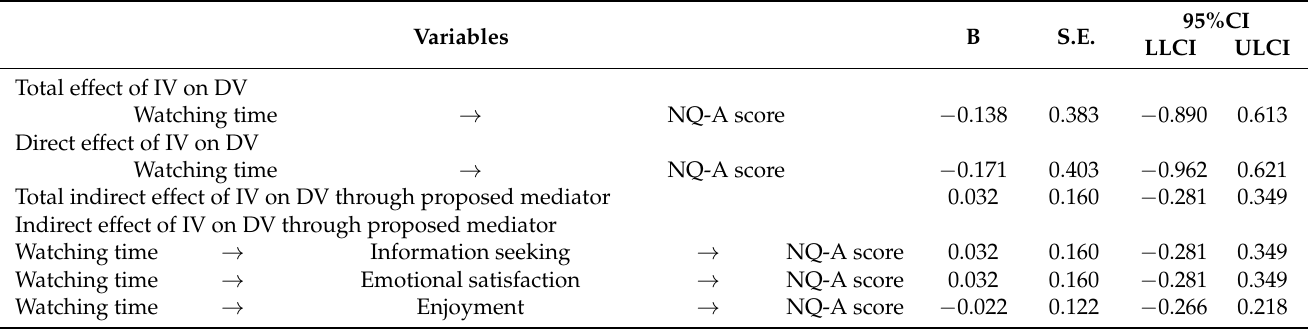
Table 5. Models of the effect of adolescents’ food content watching time on nutrition quotient with mediators of food content watching motives.